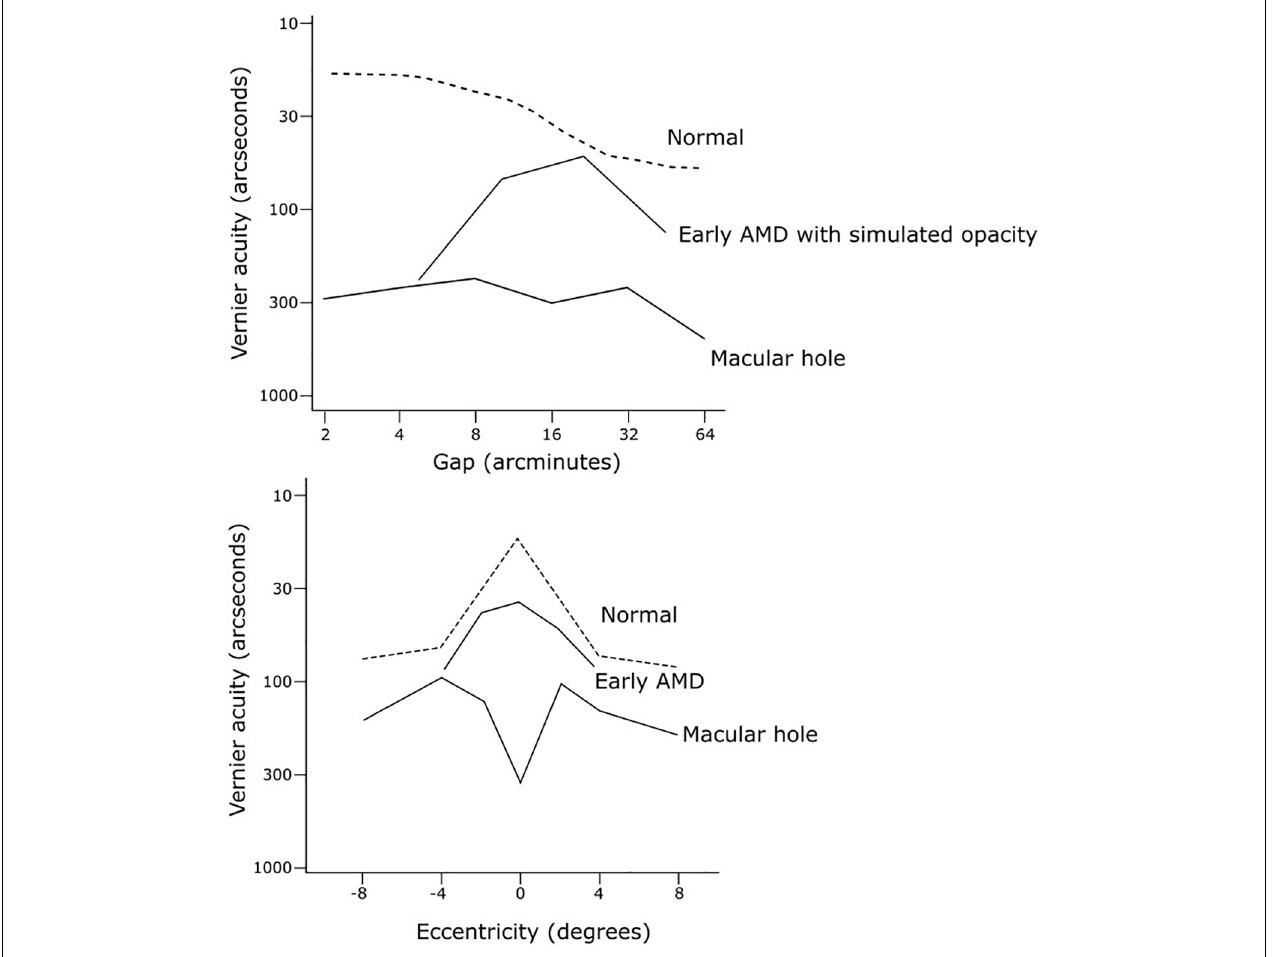
FIGURE 6 | Examples of hyperacuity gap test and hyperacuity perimetry curves from case studies by Essock et al. (1985) to discriminate visual loss due to cataract from that due to retinal pathology. The gap test curve (top) from a subject can be compared to a set of measured curves from patients with cataract resulting in varying levels of visual acuity loss. The hyperacuity perimetry curve in normal vision (bottom, dashed line) is characterised by a central sensitivity peak at the fovea, with flattening (or reversal) of this peak indicating impaired macular